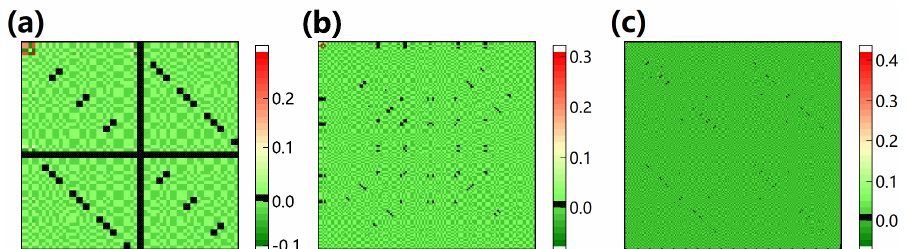
Figure A3. The real part of the final density matrices for k = 6,7,8 qubits. ( a ) The input state is | 0 (cid:105) ⊗ 6 . ( b ) The input state is | 0 (cid:105) ⊗ 7 . ( c ) The input state is | 0 (cid:105) ⊗ 8 .